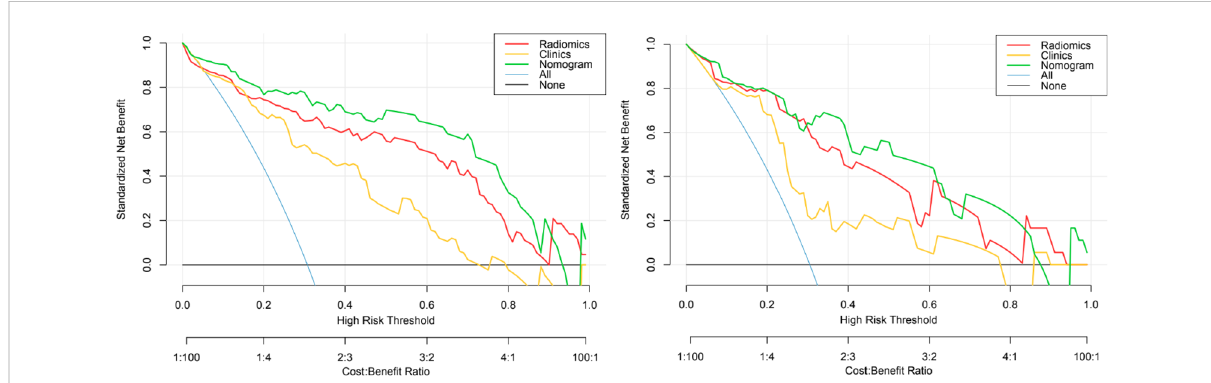
FIGURE 8 The decision curves of the clinical, radiomics nomogram, and two extreme curves were plotted based on the training and validation cohorts. The decision curves showed that if the threshold probability is > 5%, using a model with the nomogram to distinguish PTMA from LP would be more bene fi cial than a radiomics model and clinical model. LP, lobar pneumonia; PTMA, pneumonic-type mucinous